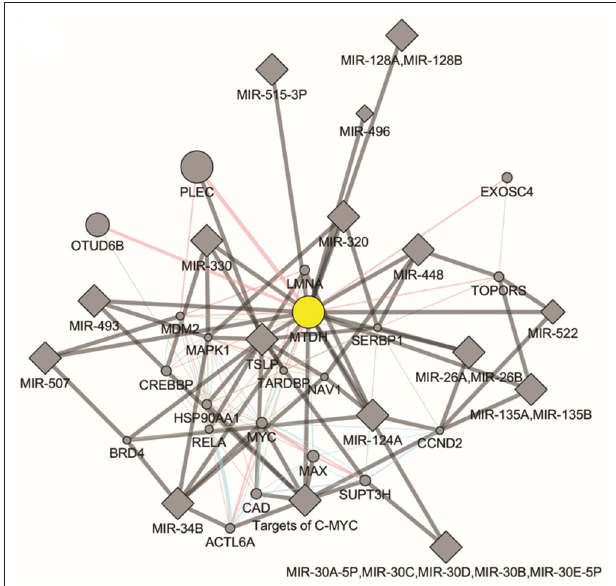
FIGURE 2 | Molecular pathways of Metadherin generated by GeneMANIA Cytoscape plugin (https://genemania.org/).